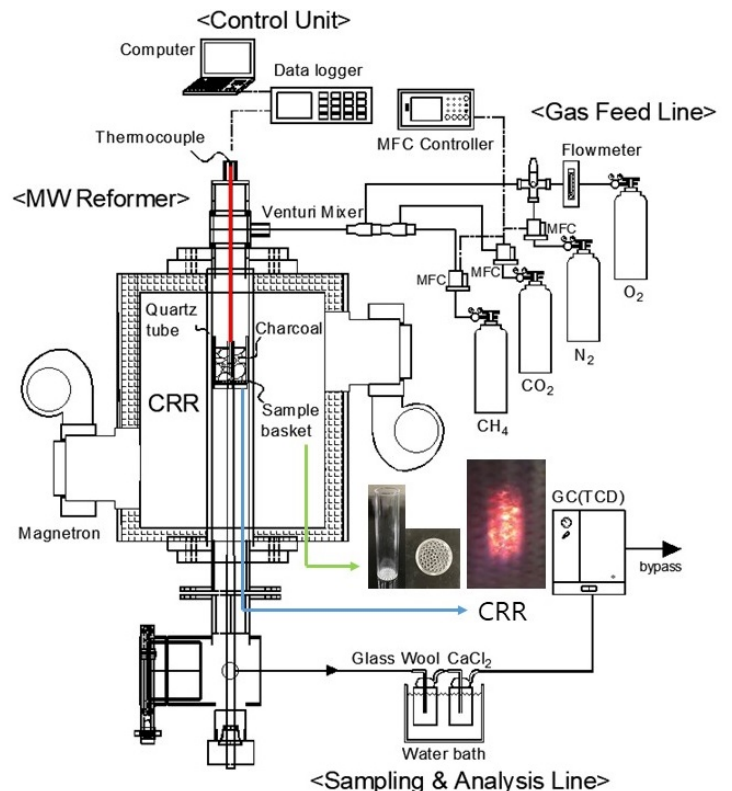
Figure 1. Experimental apparatus for a microwave heating reforming; CRR is carbon receptor reactor. Reprint with permission [13]; 2020, Springer.